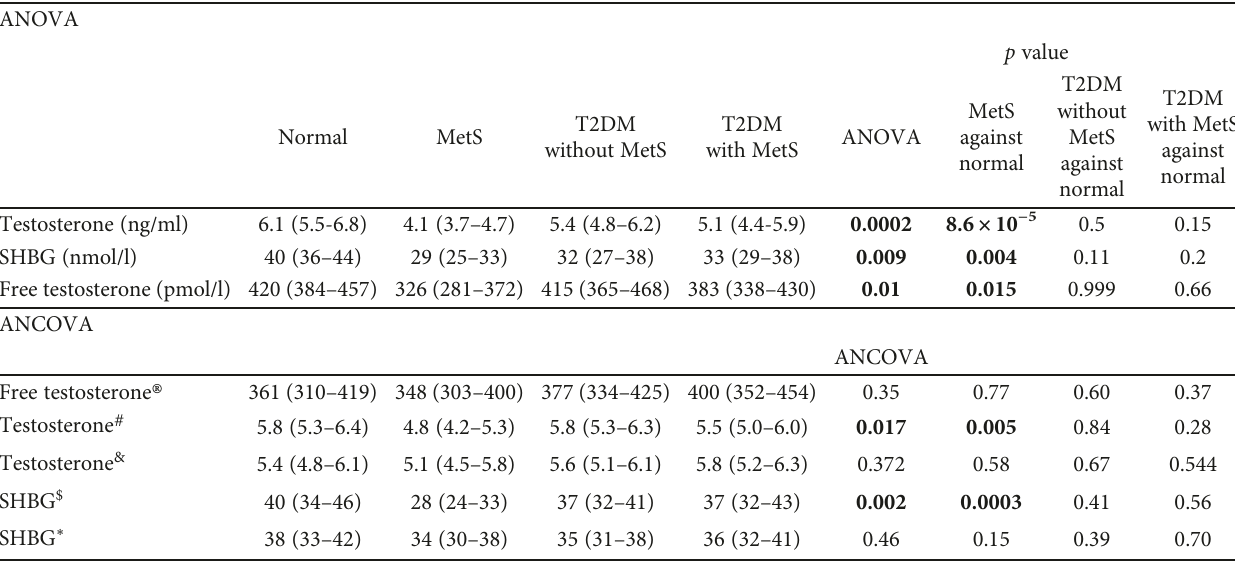
Table 4: Comparing of free and total testosterone and SHBG among di ff erent groups using ANOVA and general linear model with univariate analysis (ANCOVA).